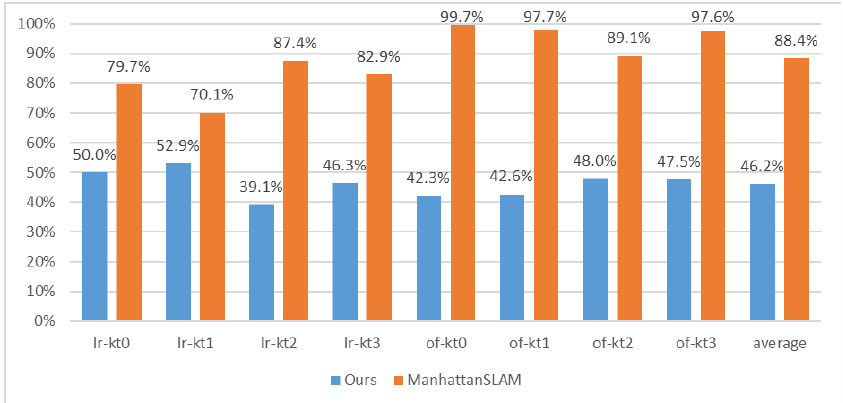
Figure 6. The percentage of MFs detected from each sequence in the ICL-NUIM dataset. Table 2. Comparison of ATE RMSE (M) for ICL-NUIM sequence.